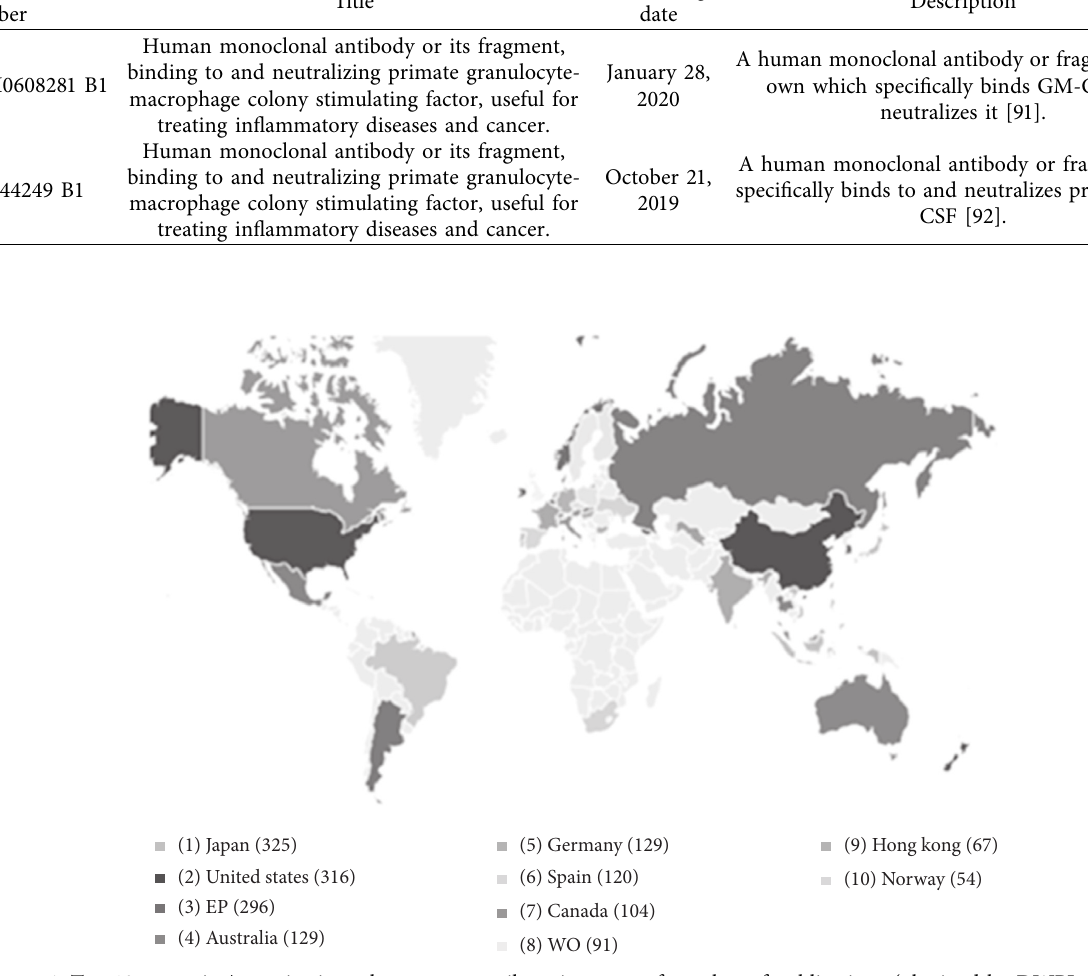
Figure 4: Top 10 countries/organizations that most contribute in terms of number of publications (obtained by DWPI database).